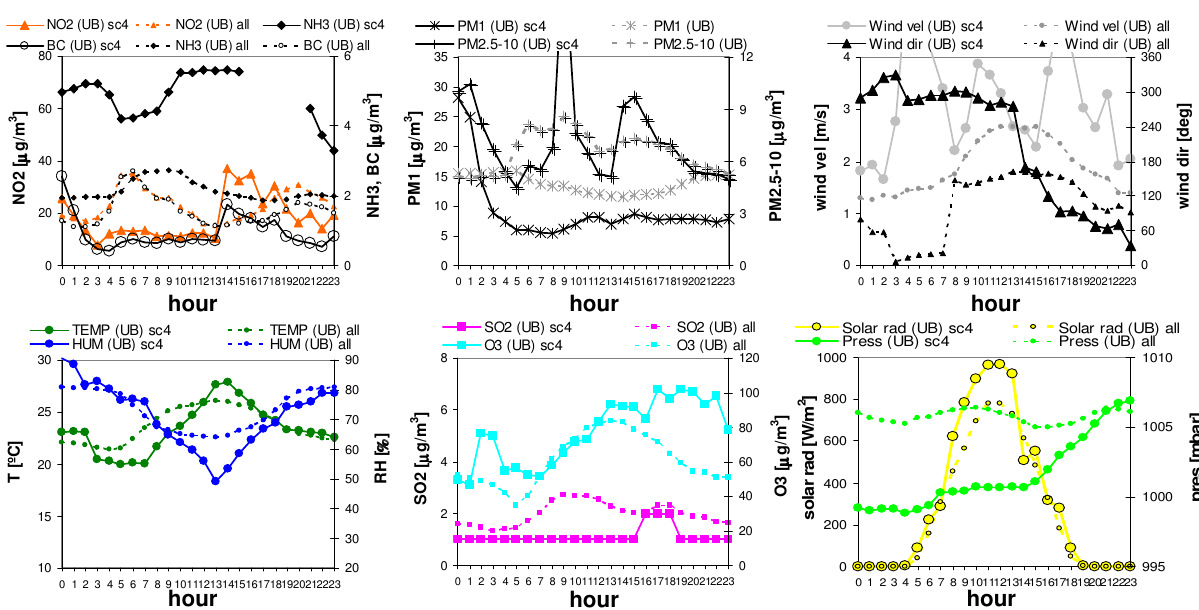
Fig. 13. Mean diurnal cycles of aerosol components and parameters measured at UB station during 13 July (Special Case